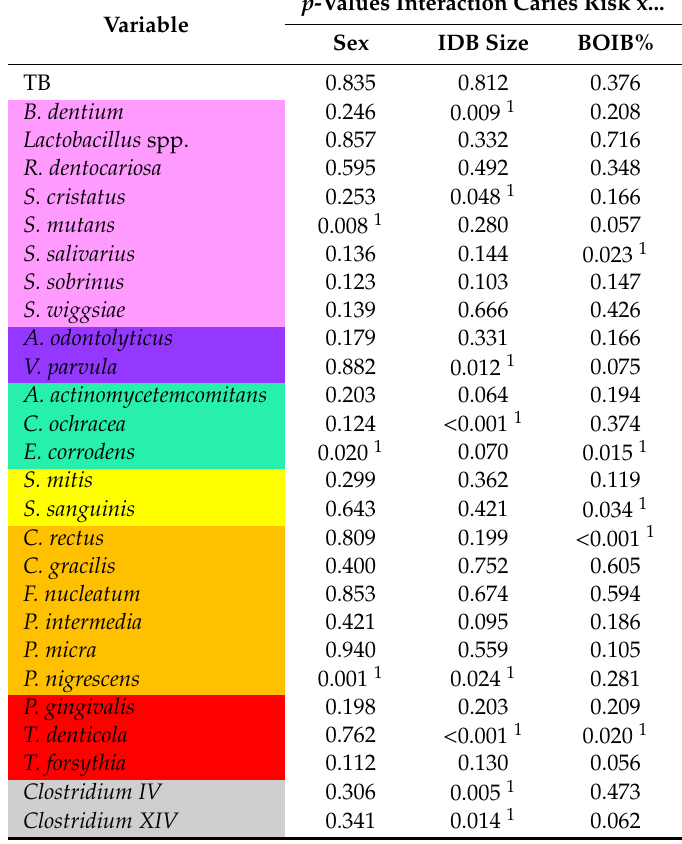
Table 5. Interactions ( p -values) between caries risk and selected variables on bacterial counts (log 10 x + 1) in 200 quadrants ( n = 50 patients × 4 quadrants / patient). p -Values Interaction Caries Risk